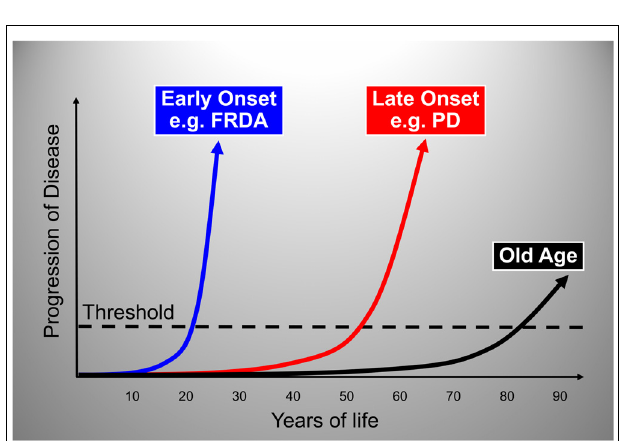
FIGURE 2 | Graphic representation of the three main modalities in the natural history of neurodegenerative disease. The rate of neurodegenerative disease progression is plotted as a function of age with an arbitrary threshold for appearance of clinical signs and symptoms.The plots show typical rates of progression for old age-related, late-onset and early-onset neurodegenerative disorders.The portion of each plot below the threshold represents the pre-symptomatic period during which the degenerative process is already active. FRDA, Friedreich ataxia; PD, Parkinson